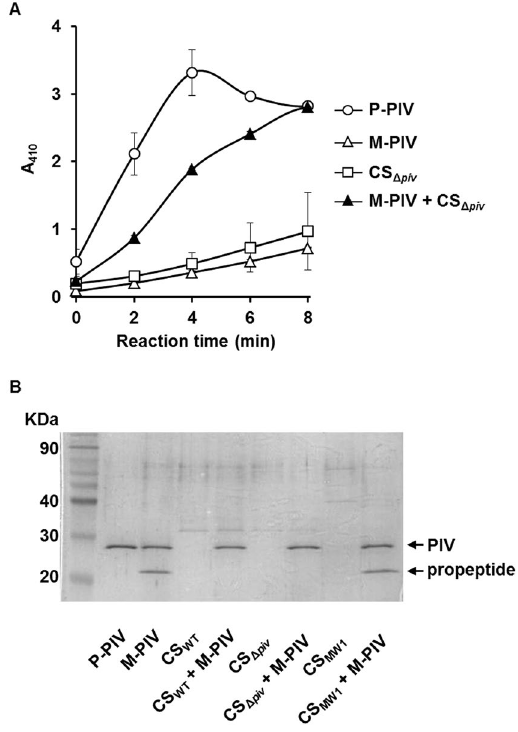
Figure 3. Activity restoration of M-PIV and propeptide degradation by CS from QS-positive strain. ( A ) 100 ng of M-PIV was mixed with 2 μ l of 10 times-concentrated CS from Δ piv (CS Δ piv ) and the PIV activity was promptly measured without incubation. As controls, same amount of M-PIV, P-PIV, and CS Δ piv were measured for the PIV activity in the same condition. ( B ) CS Δ piv was mixed with 400 ng of M-PIV in 25 μ l reaction volume and incubated at room temperature for 30 min. For a control, the CSs from wild type (CS WT ) or MW1 (CS MW1 ) were mixed and incubated with M-PIV in the same condition. All reactions were applied to SDS-PAGE and visualized by Coomassie staining. The propeptide and PIV bands are indicated. This gel picture was cropped and the full-length gel picture is presented in Fig.